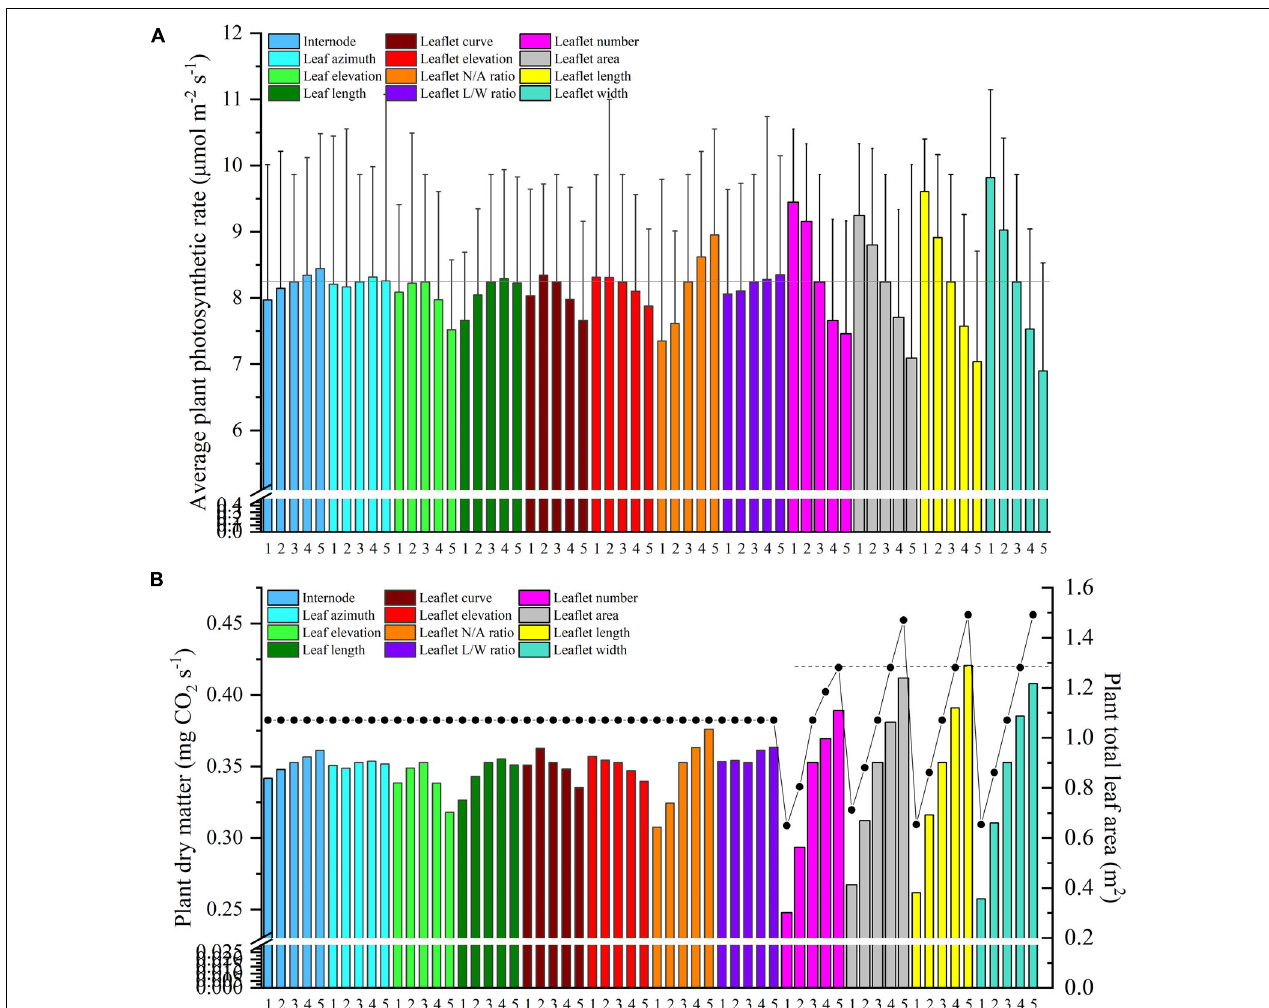
FIGURE 12 | Midday plant average photosynthesis (A) and dry matter (B) of different leaf and leaflet level architectural shapes under the homogeneous canopy (planting pattern 1) of N–S orientation with P = 0.65 m and S = 0.3